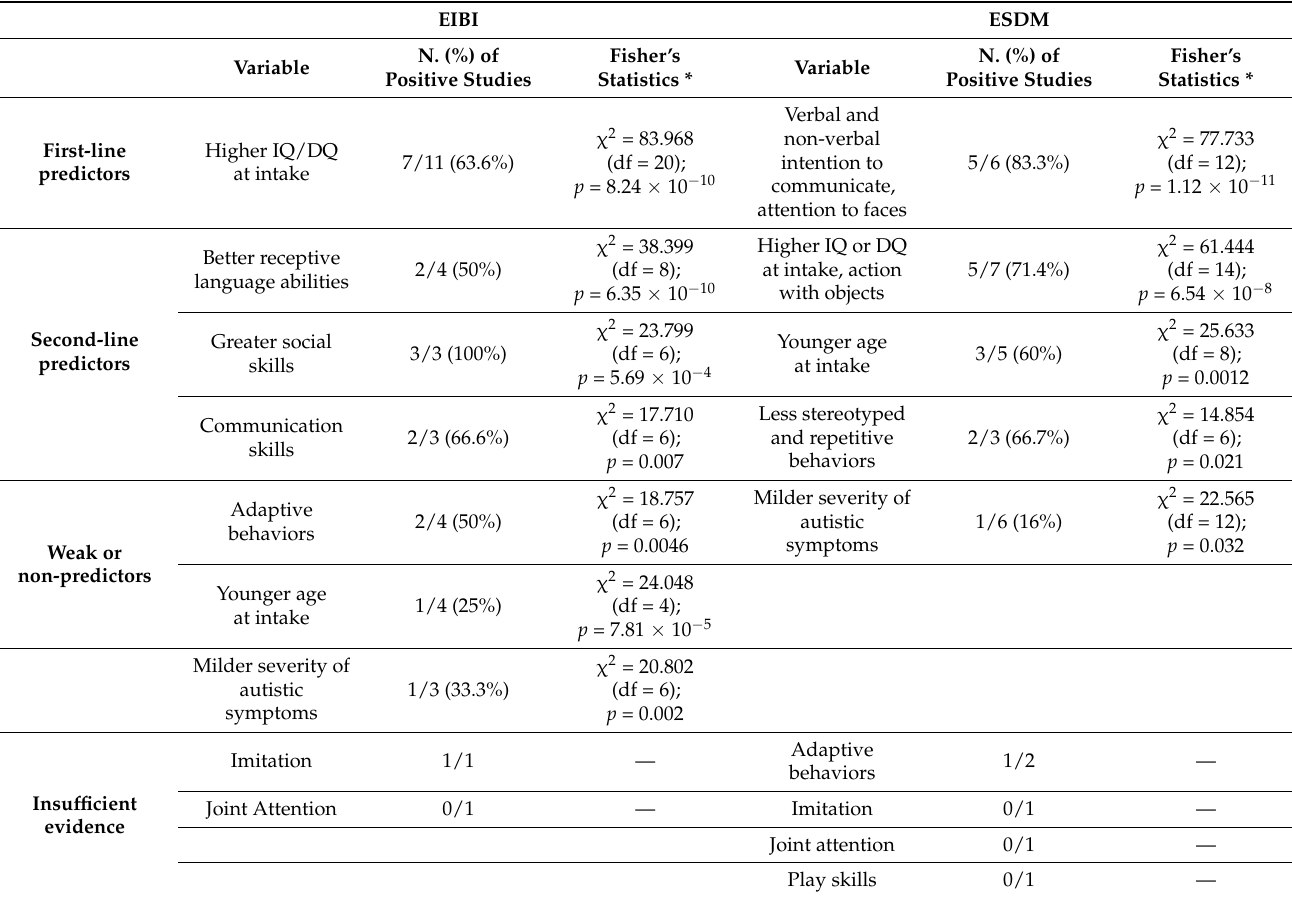
Table 7. Predictors of better response to EIBI and to ESDM, categorized based on number of published articles, percentage of positive studies, and combined p -value obtained using the Fisher’s method [55]. EIBI ESDM N. (%) of Fisher’s N. (%) of Fisher’s Variable Variable Positive Studies Statistics * Positive Studies Statistics